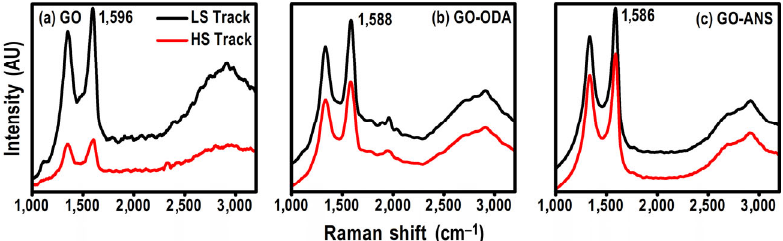
Fig. 12 Raman spectral study of tribo film generated with microtribological ball-on-disc experiments on worn disc tracks by (a) GO, (b) GO-ODA, and (c) GO-ANS particles in LS and HS ambient condition.